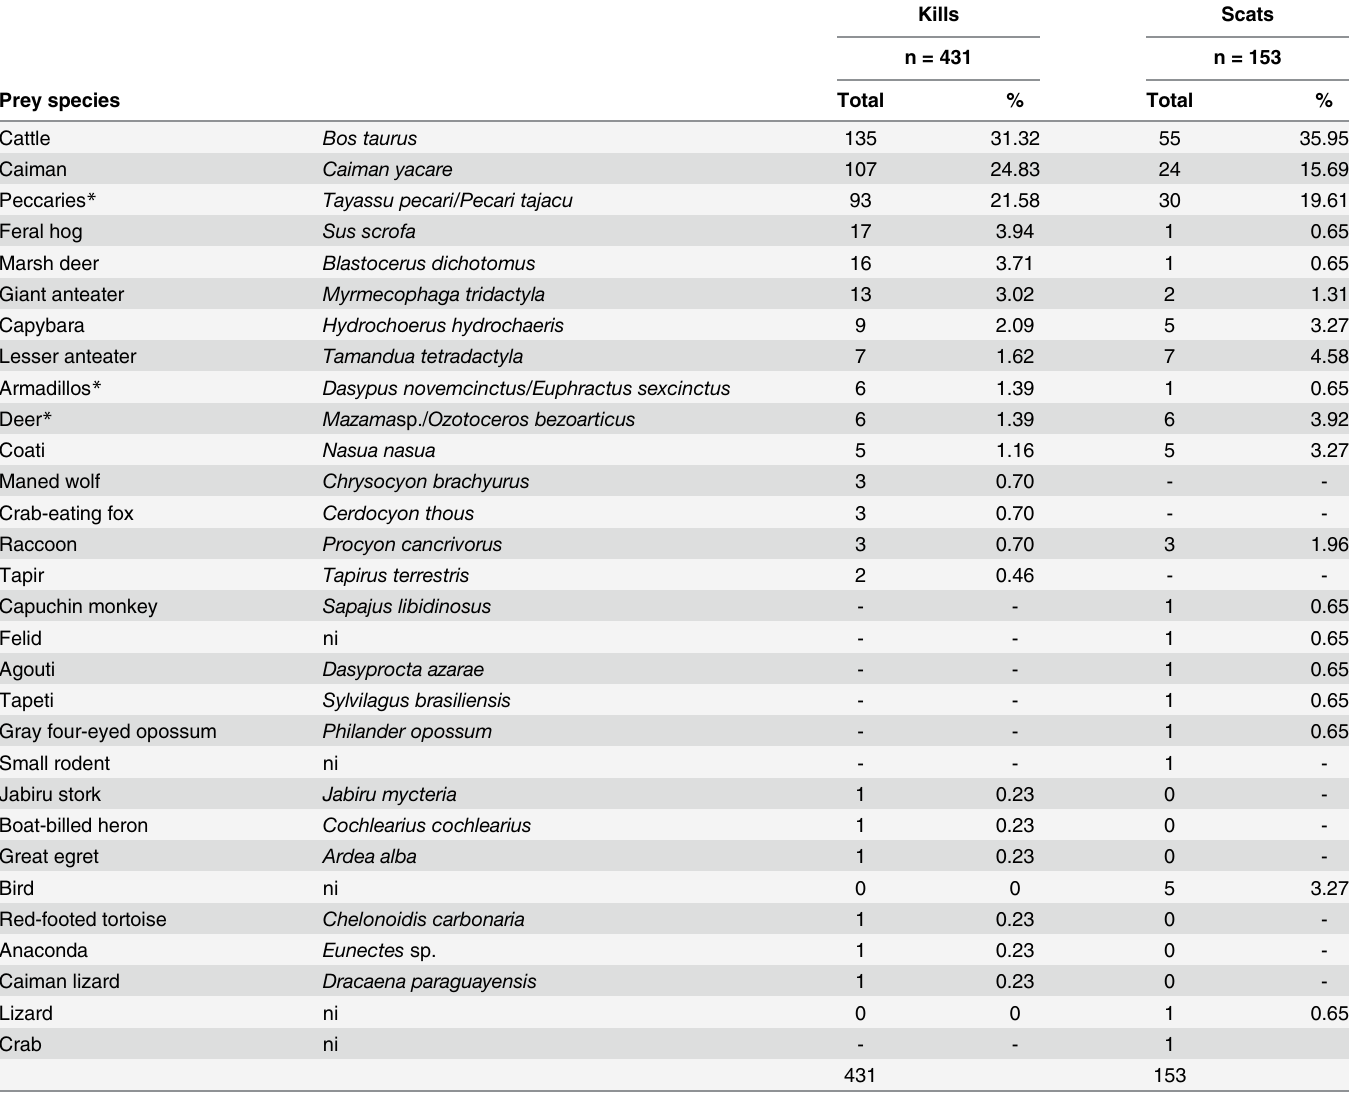
Table 1. Jaguar prey species identified through two main methods, kills found at GPS location clusters of 10 radio-collared jaguars, and prey remains found in 125 scats. November 2001 to April 2004, southern Pantanal,